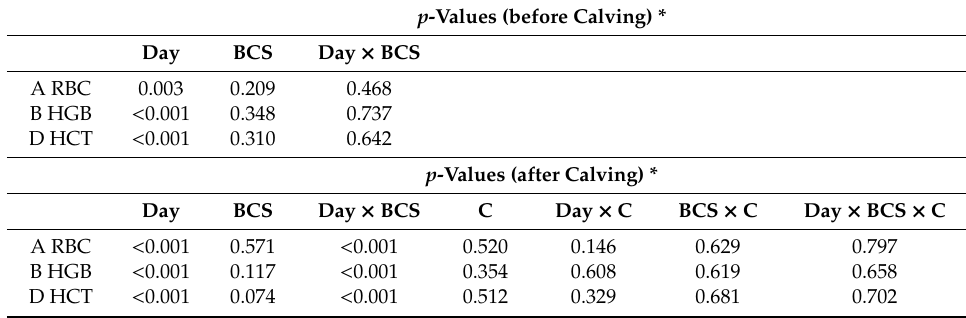
Table A1. Model corresponding to Figure A1. p -Values (before Calving) *